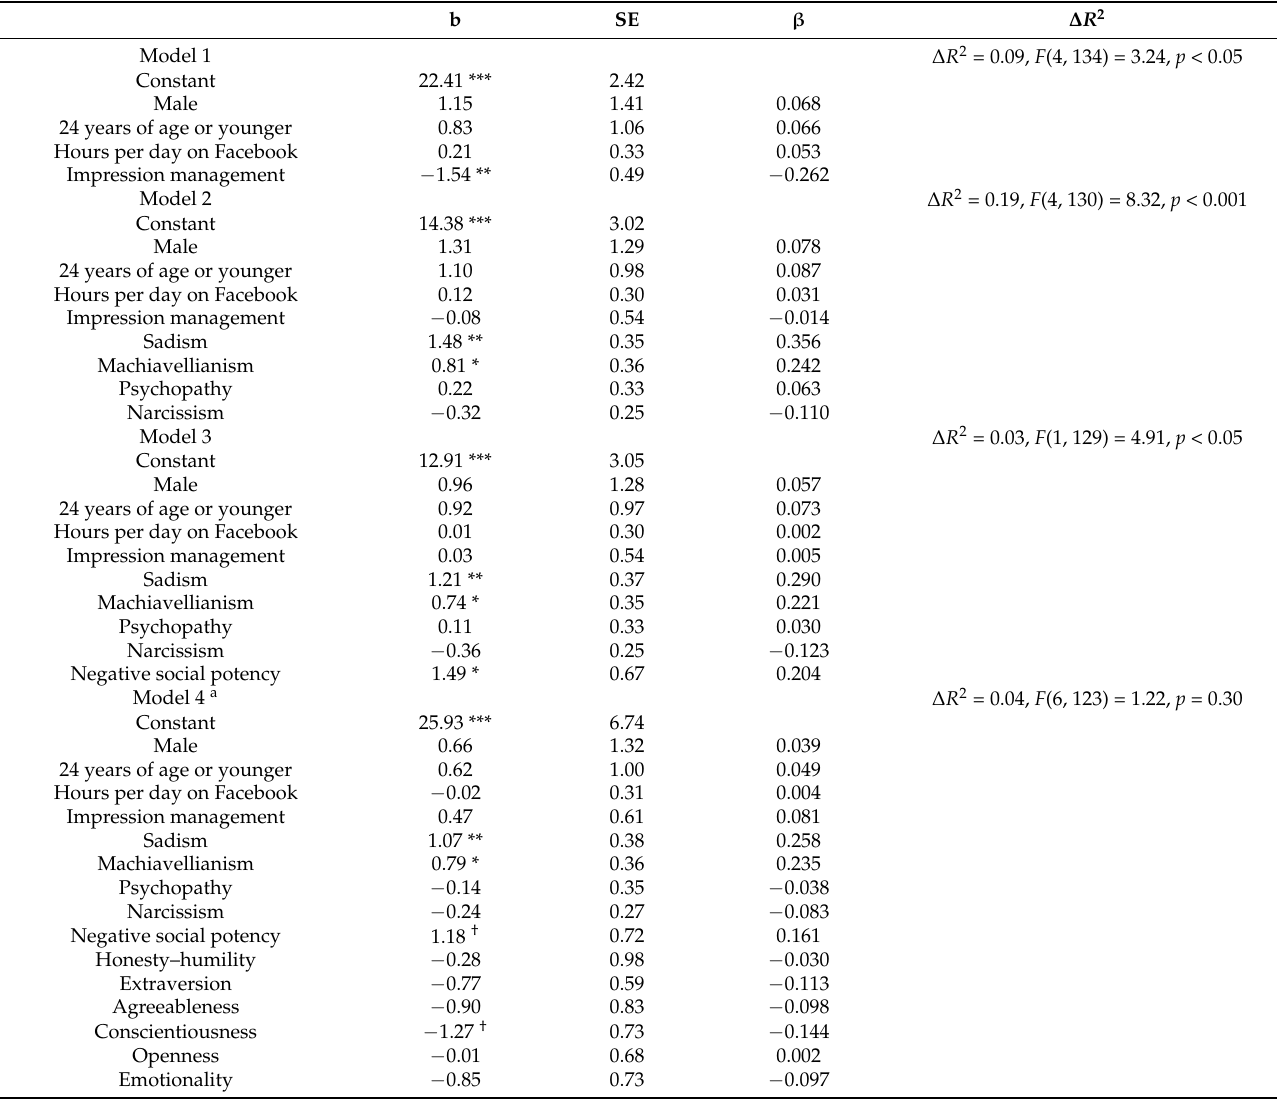
Table 2. Summary of the hierarchical regression analysis predicting Facebook trolling behaviors. b SE β ∆ R 2 Model